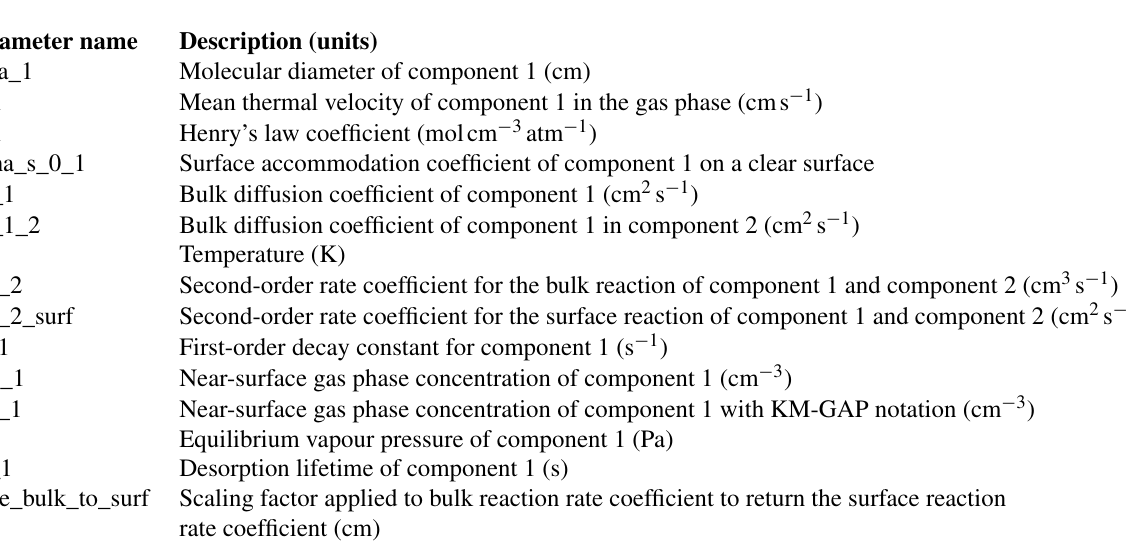
Table of variable names, descriptions and units supplied to models created in MultilayerPy. The unit of length in these models is cm and the units for surface and bulk concentra- tions of model components are cm − 2 and cm − 3 ,